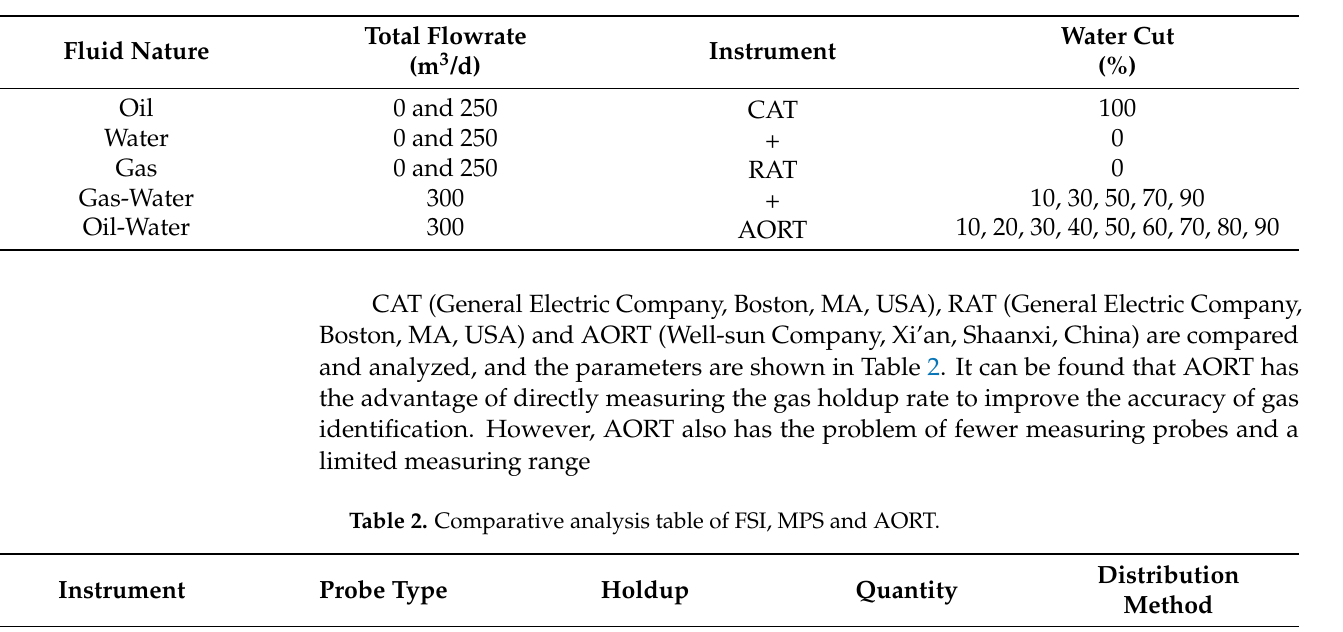
Table 1. Simulation experiment measurement scheme.